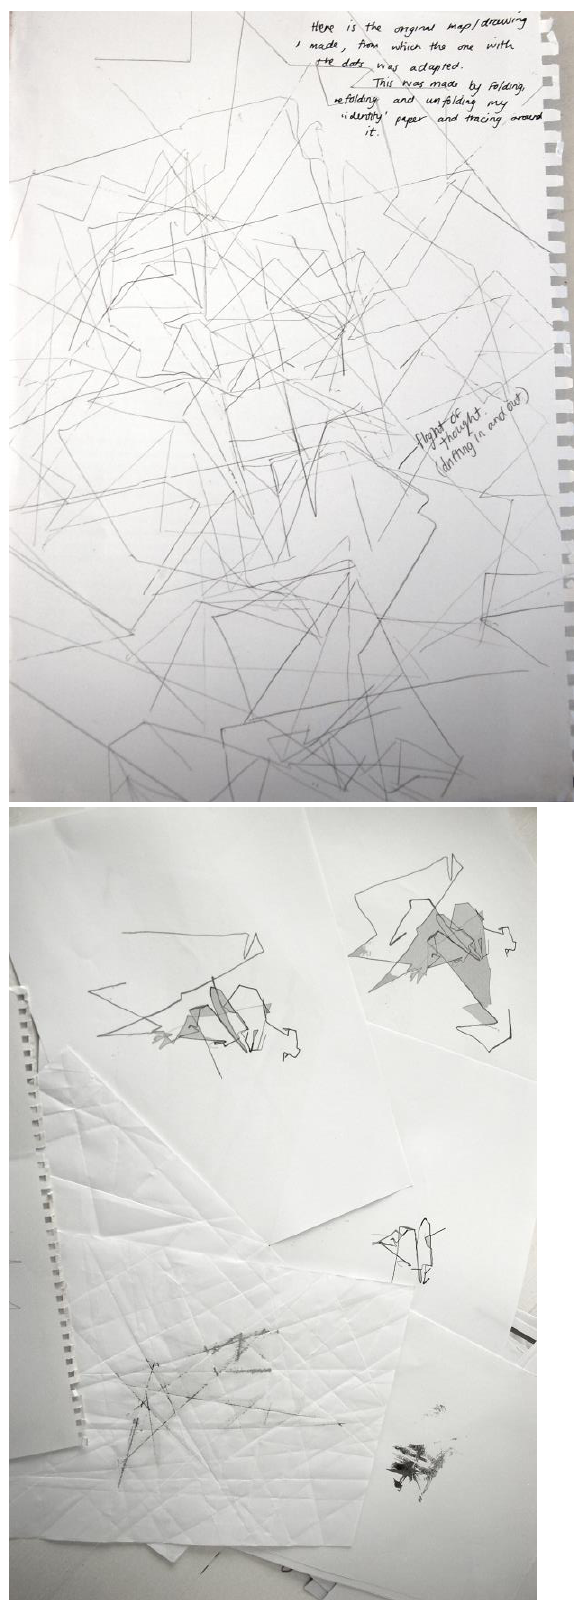
Figure 1.2-1.3 : Project 2: Process development (directed visual exploration and mark making exercises with paper folding) (Source: Hannah,